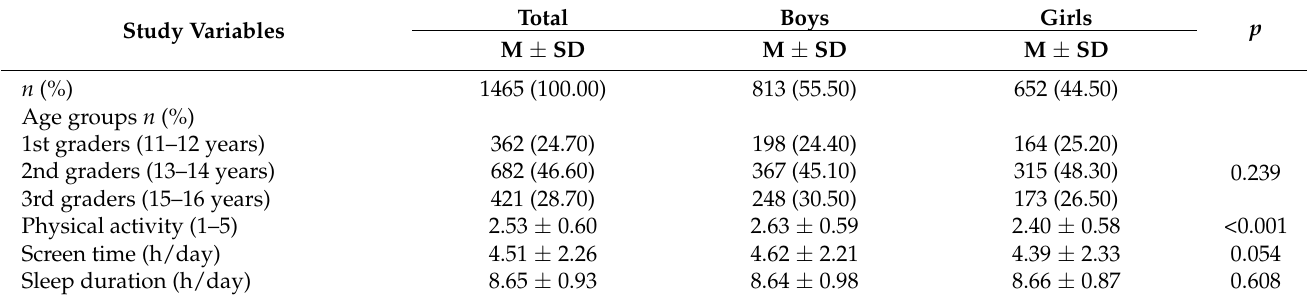
Table 1. Descriptive characteristics of the participants and prevalence of the three 24-hour Movement Behaviours among boys and girls.